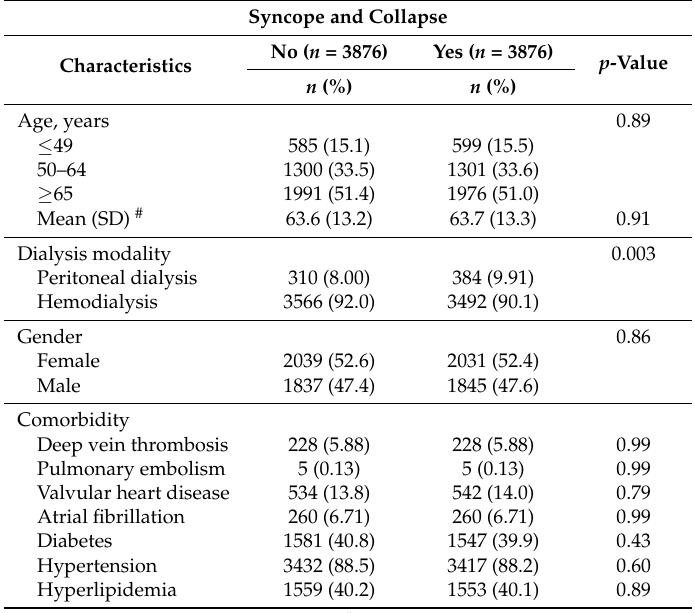
Table 1. Comparison of demographics and comorbidities between dialysis patients with and without syncope and collapse